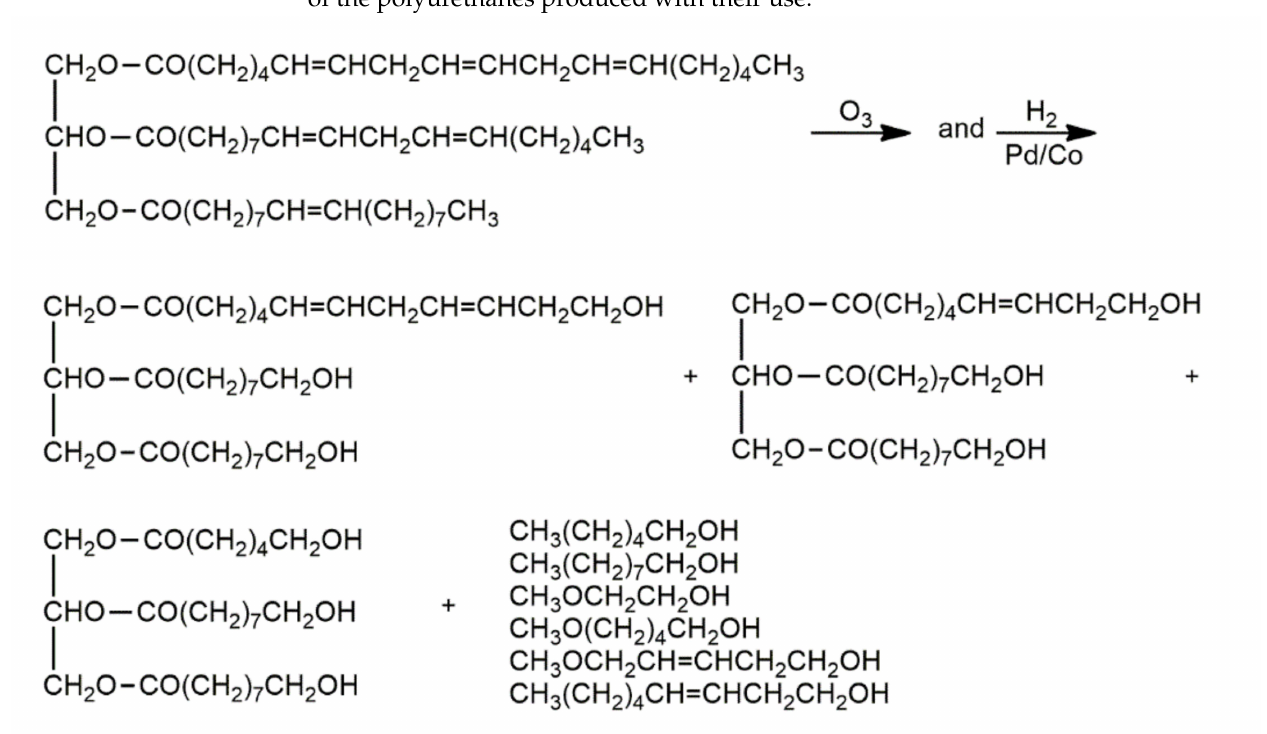
Figure 8. Preparation of polyols from vegetable oils by